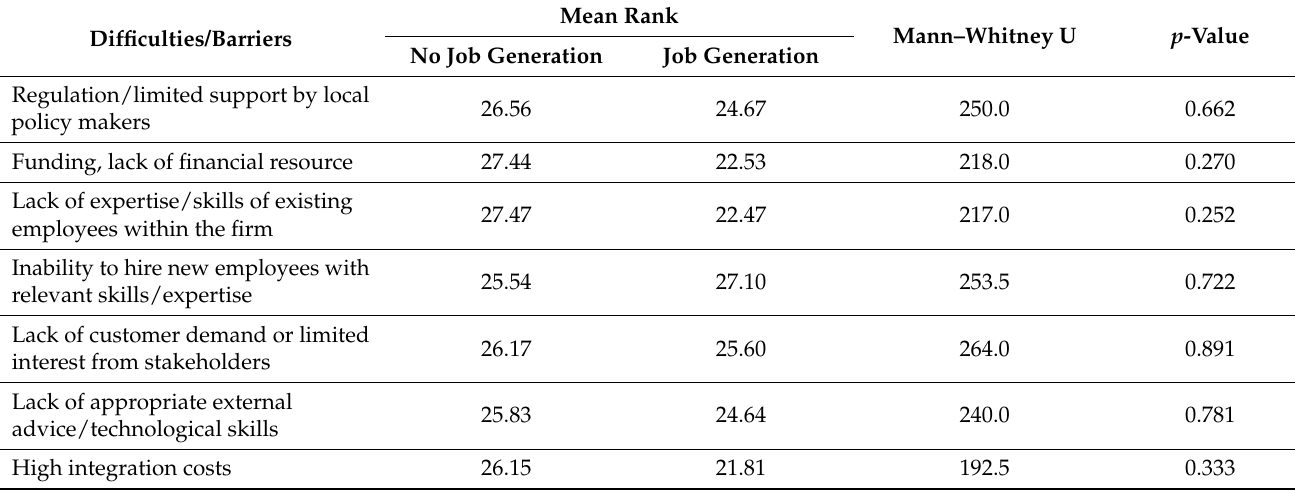
Table 4. Difficulties/barriers of rural SMEs during the adoption/integration of new technology—job generation.